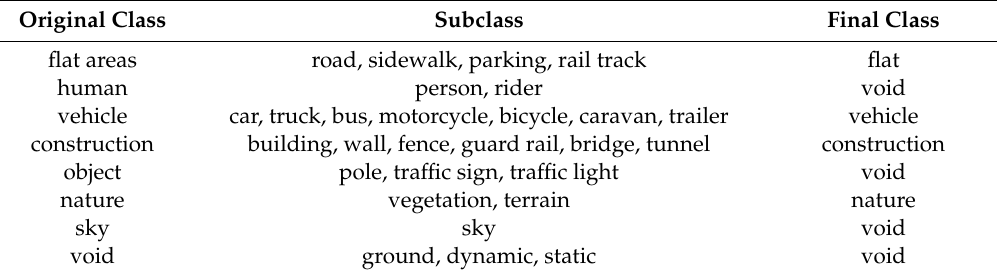
Figure 4. Examples from the Cityscape dataset: ( a , d ) RGB-images, ( b , e ) original label images, and ( c , f ) redefined label images. Table 2. Original, subclass, and final classes of the Cityscape dataset.